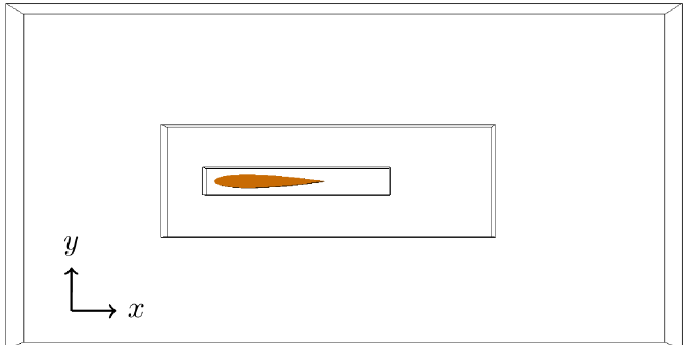
Figure 5. Sketch (not to scale) of nested boundaries of Grids 1–3 (black lines) with the foil marked in orange of the Nested grid set-up defined in (Table